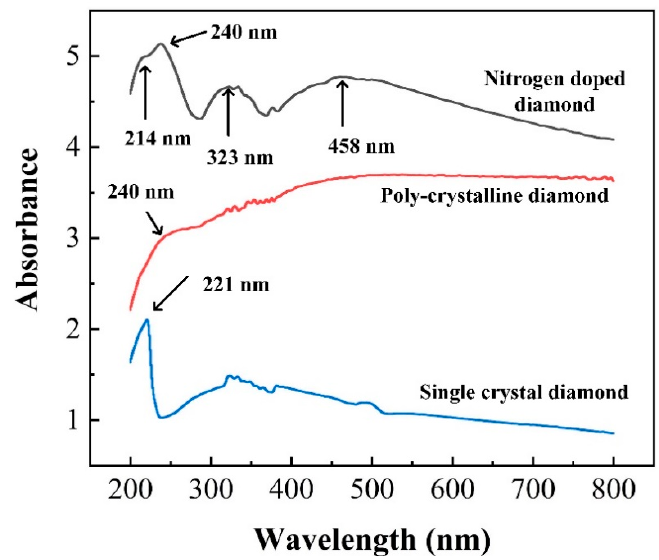
Figure 6. Contrast for absorbance spectra of nitrogen-doped diamond (black line), polycrystalline diamond (red line), and SCD (blue line) in visible and UV regions.